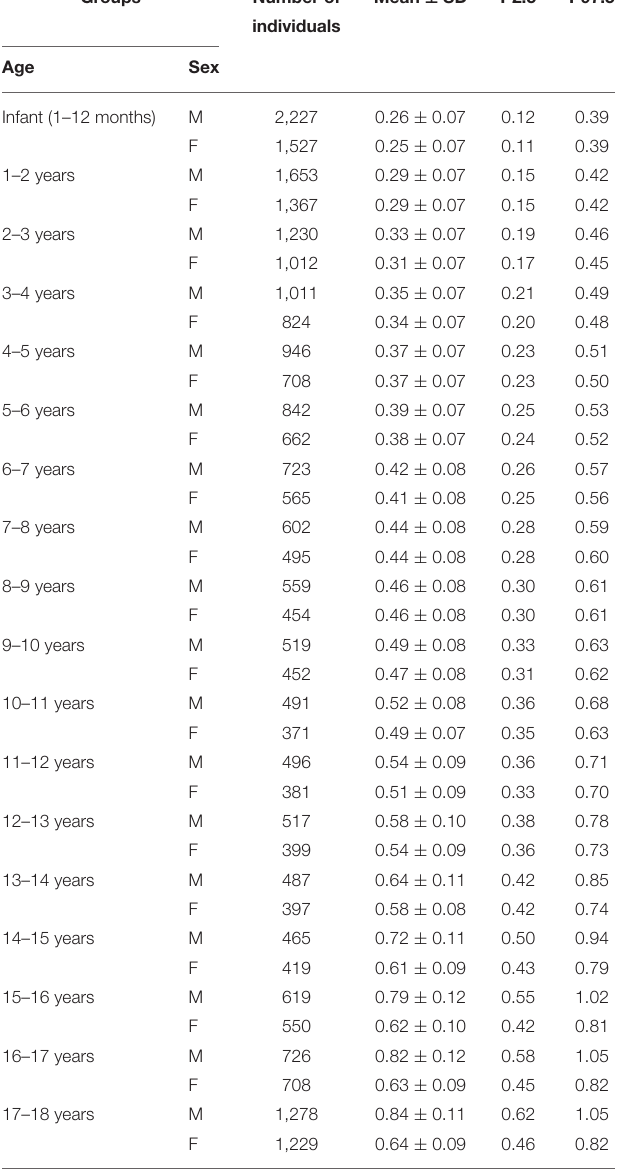
TABLE 1 | Reference intervals for serum creatinine (mg/dL) in each age- and sex-specific group. Groups Number of Mean ± SD P2.5 P97.5